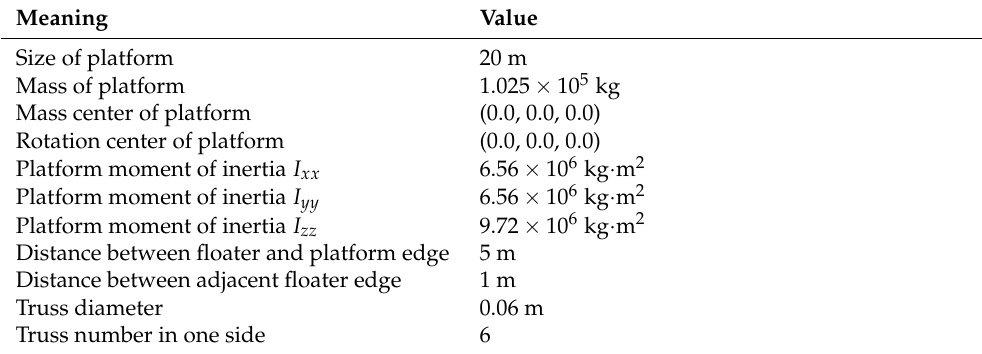
Table 2. Parameters of the platform.